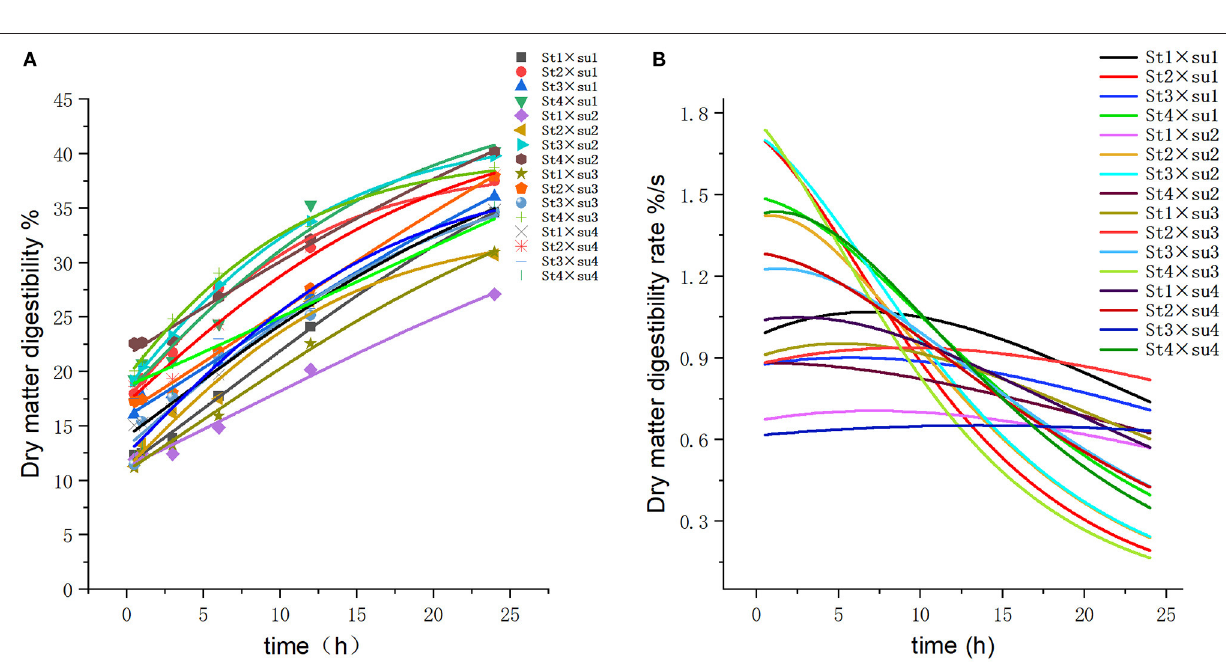
(12.92%), Tenericutes (2.30%), and Verrucomicrobia (2.18%) being the most abundant. The predominant bacterial taxa at the genus level (with relative abundance being > 0.10% in each (20.57%), Prevotella (20.17%), Ruminobacter (10.54%),